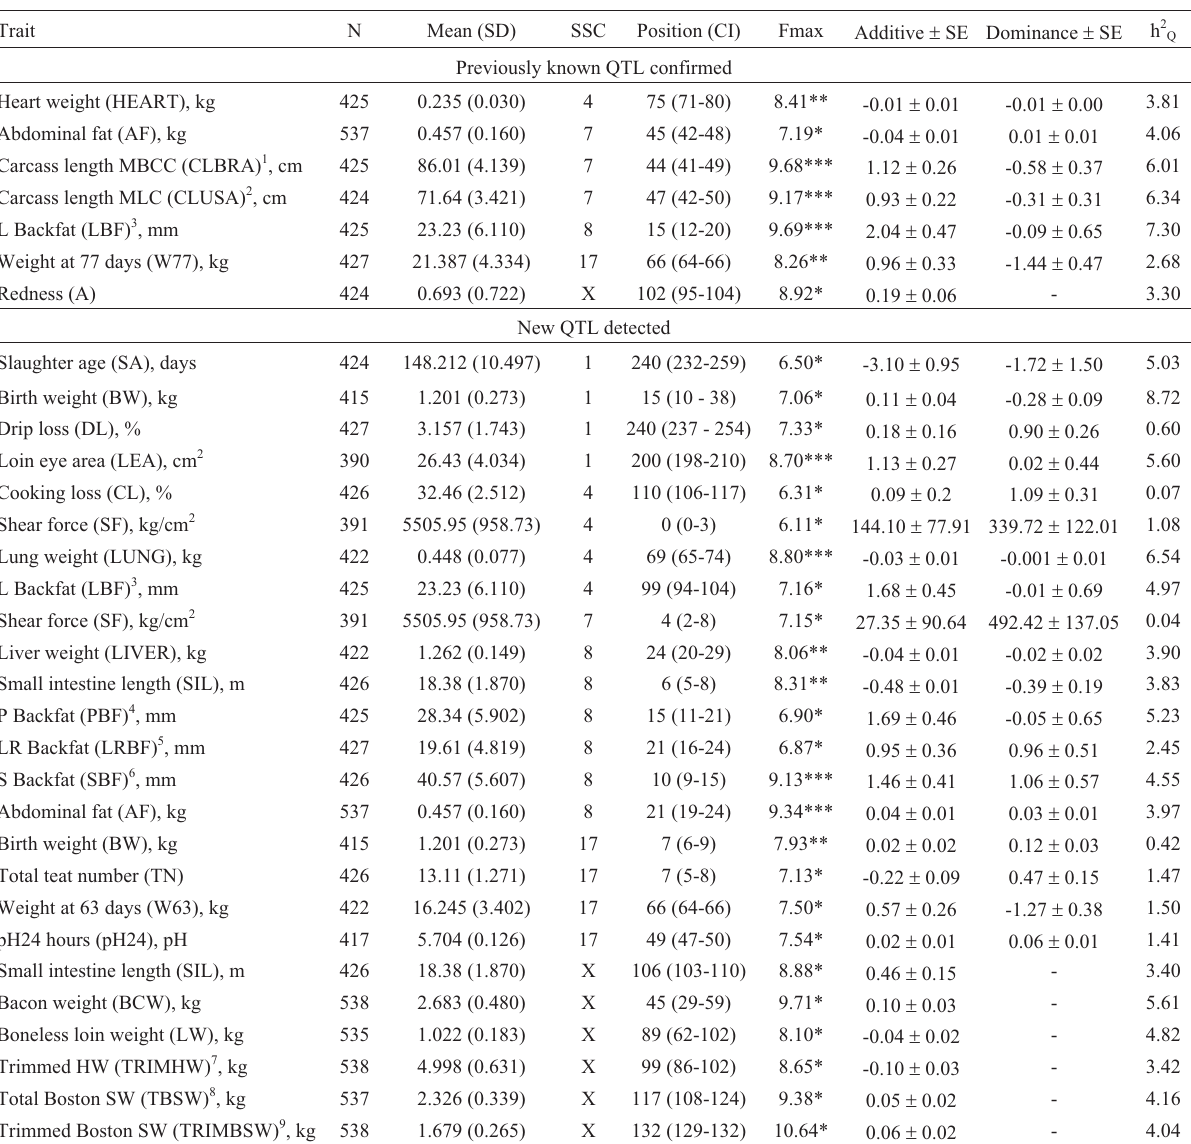
Table 2 - Evidence for significant QTL for various traits. Number of animals analyzed for each trait (N), phenotypic mean (standard deviation), location, confidence interval at 95% (CI), maximum F statistics (Fmax), estimates of additive and dominance effects, standard errors (SE) and % of phenotypic variance in the F2 explained by each QTL (h 2 Q ) for significant traits on Sus scrofa chromosomes 1, 4, 7, 8, 17 and